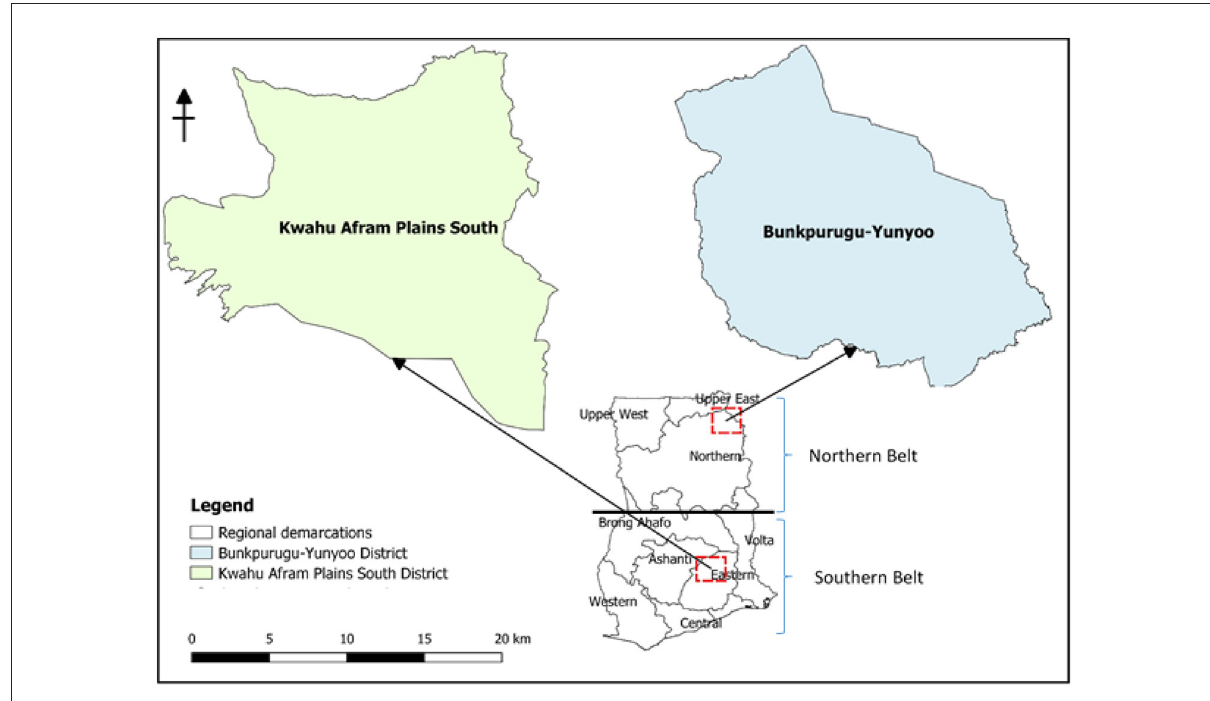
FIGURE1 Map of Ghana showing the study